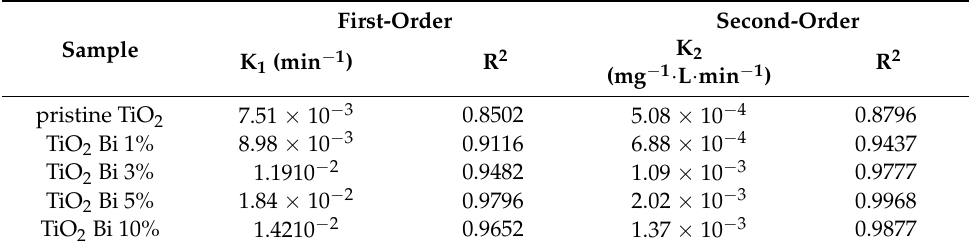
Table 4. Rate constants for kinetic studies of MB photodegradation using pristine TiO 2 and